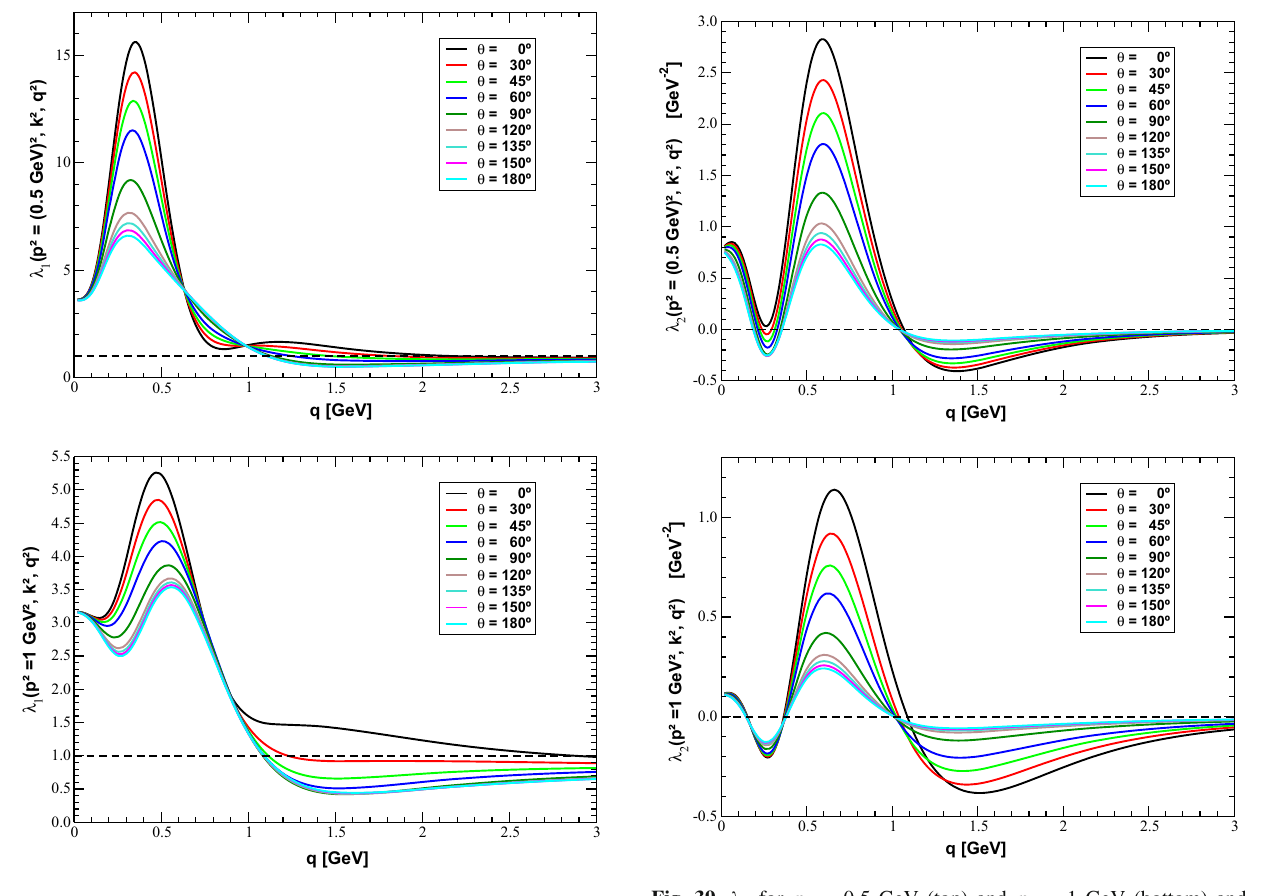
Fig. 38 λ 1 for p = 0 . 5 GeV (top) and p = 1 GeV (bottom) and various θ